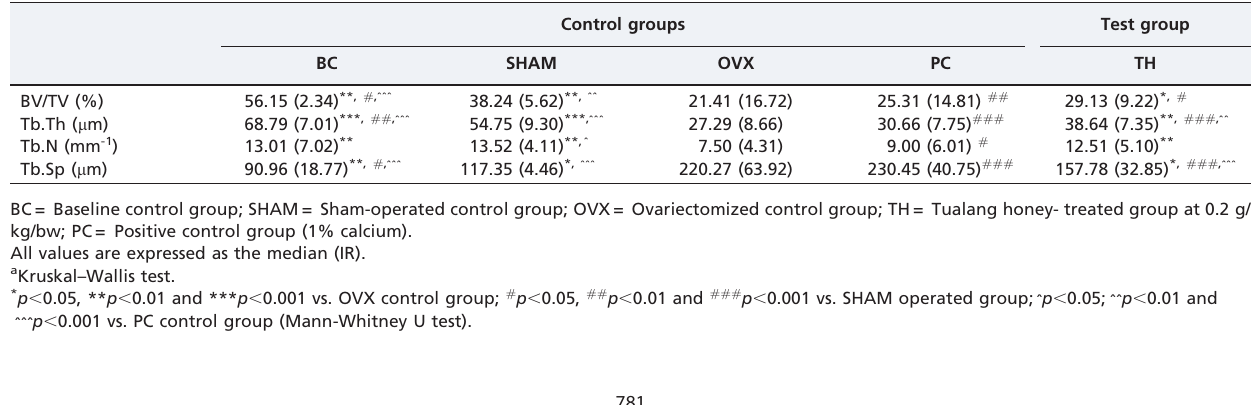
Table 2 - Effects of Tualang honey on bone